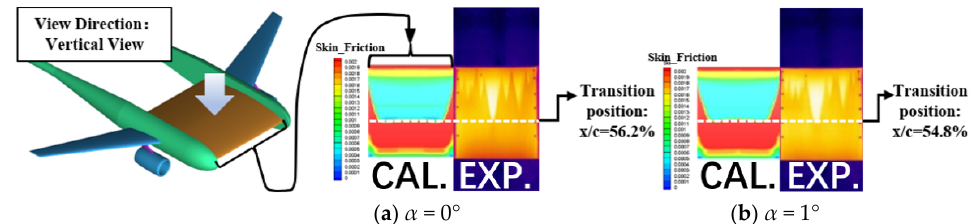
Figure 6. Transition comparison of experiment and calculation results in the central experimental wings.